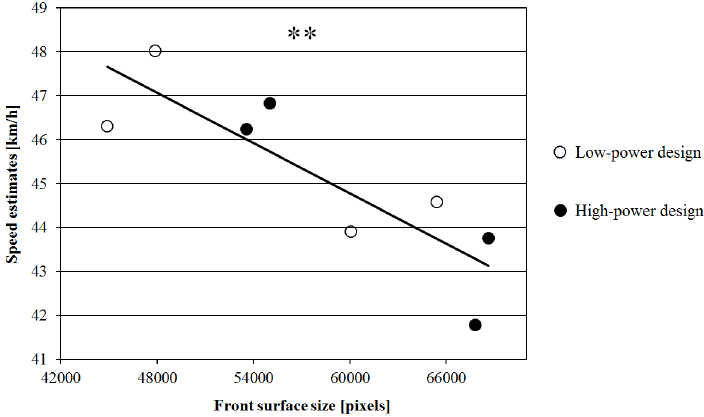
Fig 5. Correlation between front surface size and mean speed